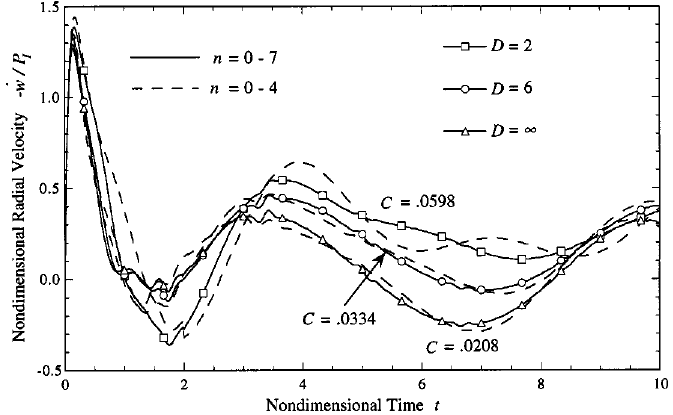
Fig. 8. Shell radial-velocity histories at (cid:18) = (cid:25) for an empty spherical shell excited by spherical step-exponential waves ( (cid:12) = 2).